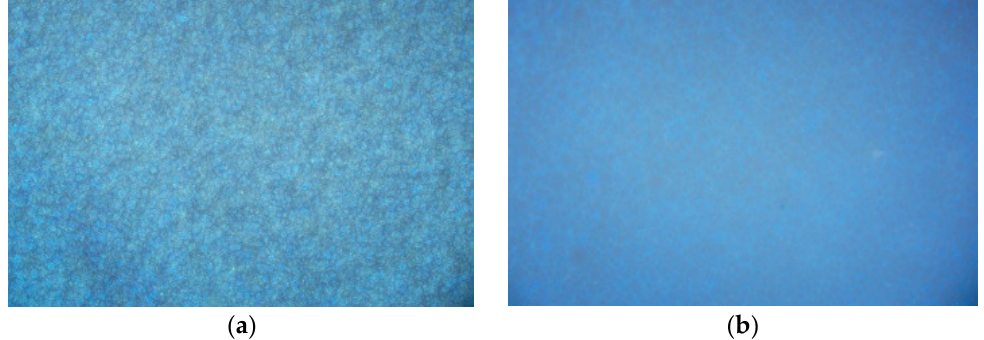
Figure 8. Fluorescent micro-structure of WE/A with 15% WER ( a ) 1 h; ( b ) 48 h.